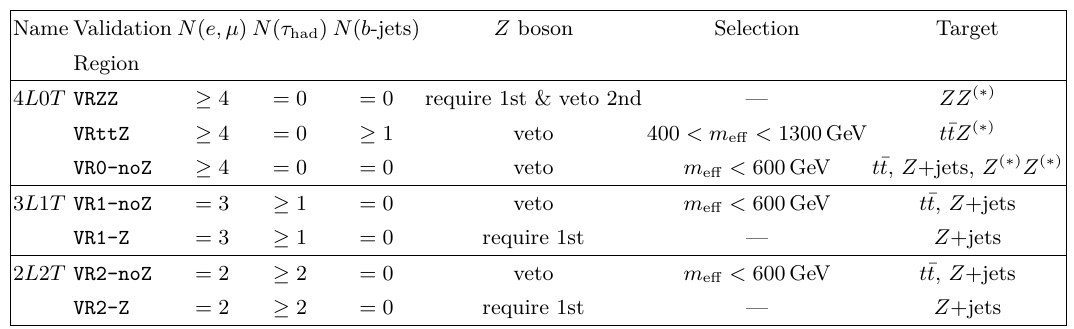
Table 7. Validation region definitions. The Z boson column refers to the Z veto or selection of a first/second Z candidate as described in the text.